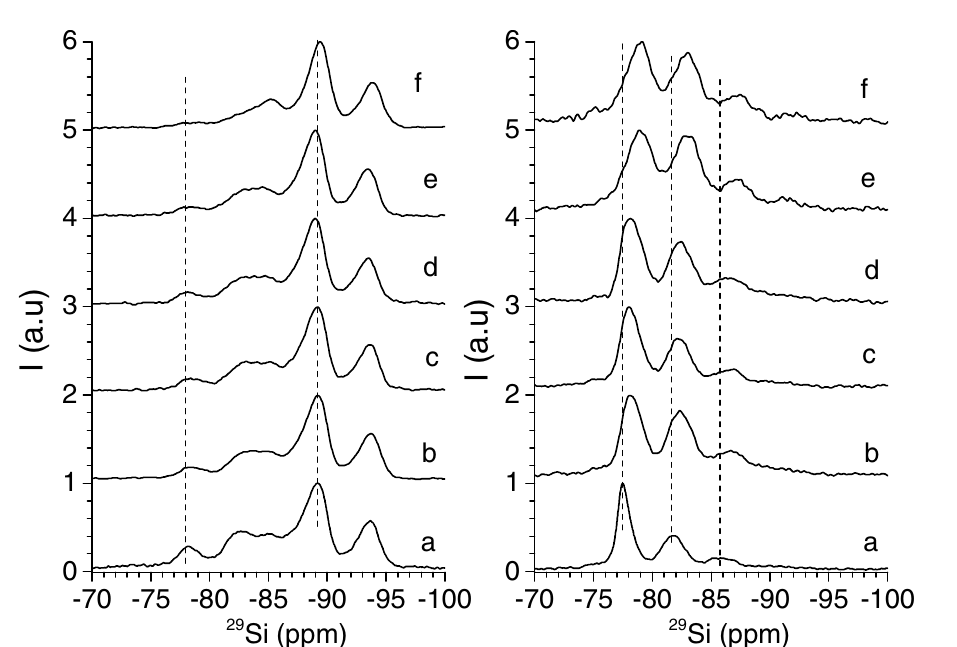
Figure 4. 29 Si MAS NMR spectra of Mica-2 ( n = 2), left graph, and, Mica-4 ( n = 4), right graph. ( a ) NaM n , ( b ) Ch-NaM n -A, ( c ) Ch-NaM n -B, ( d ) Ch-NaM n -C, ( e ) Ch-NaM n -D, and, ( f ) Ch-NaM n